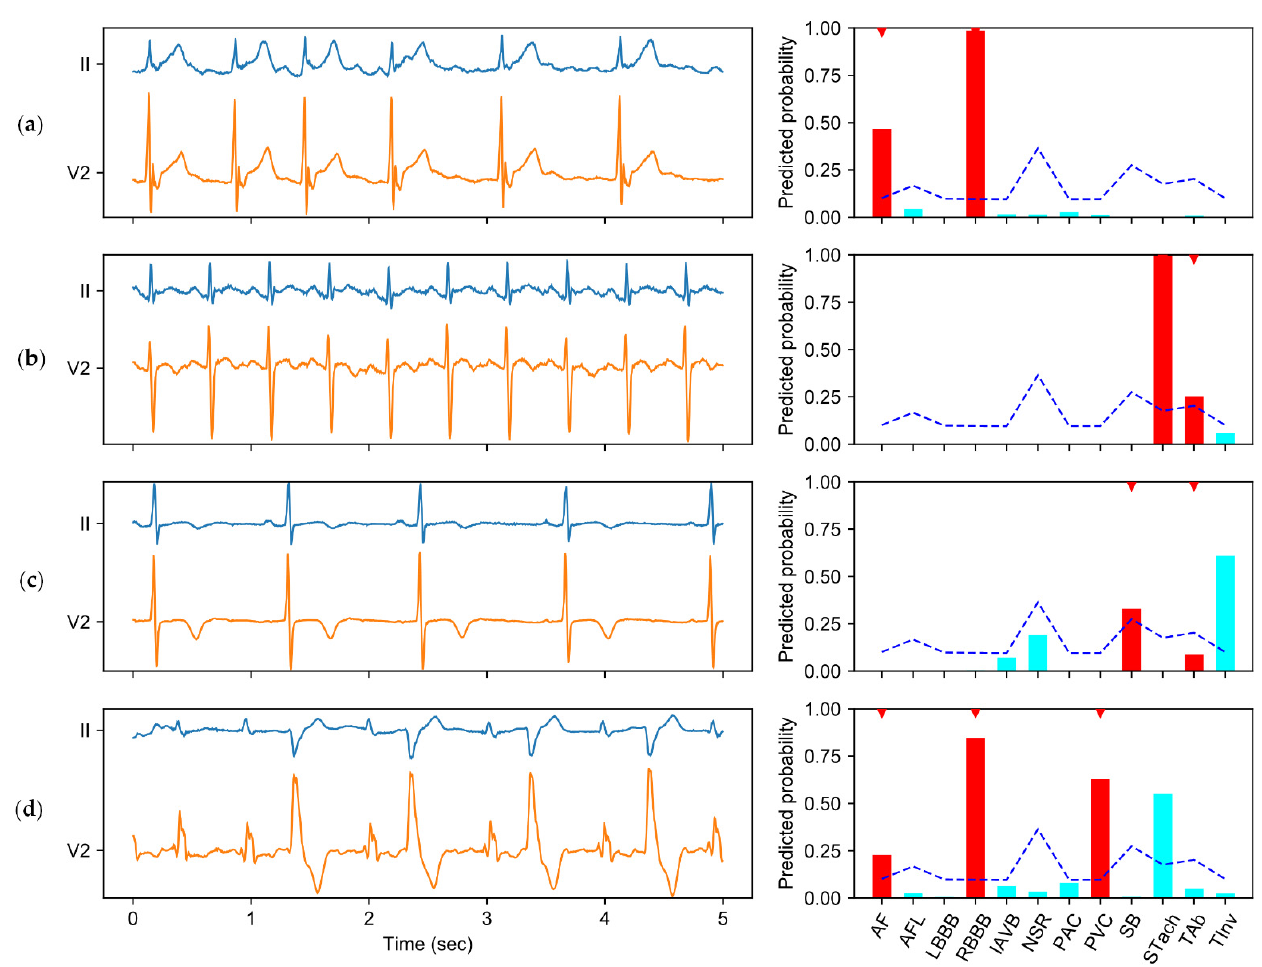
Figure 5. Instances of ECG recording and model predictions. The subgraph on the left of each row shows the ECG signal (including lead II and lead V2), while the subgraph on the right shows the model predictions for the left ECG signal. The predicted probabilities for the physician-annotated labels are in red bars and marked with red downward triangles above the bars, while the predictions for other labels are shown in the cyan bars. The thresholds calculated by CICST are shown in blue dashed lines. Four instances are shown in this figure: ( a ) an ECG recording with annotated labels of atrial fibrillation (AF) and right bundle branch block (RBBB); ( b ) an ECG recording with labels of sinus tachycardia (STach) and T-wave abnormal (TAb); ( c ) an ECG recording with labels of sinus bradycardia (SB) and TAb; and ( d ) an ECG recording with labels of AF, RBBB, and premature ventricular contraction (PVC). This figure also shows the predicted probabilities for other labels, including atrial flutter (AFL), left bundle branch block (LBBB), first-degree atrioventricular block (IAVB), normal sinus rhythm (NSR), premature atrial contraction (PAC), and T-wave inversion (TInv).